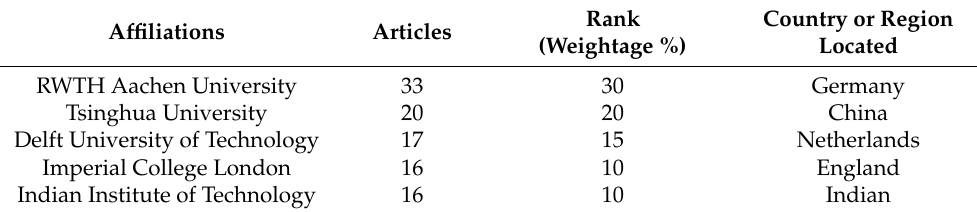
Table 3. Institutions with the highest citation rate.